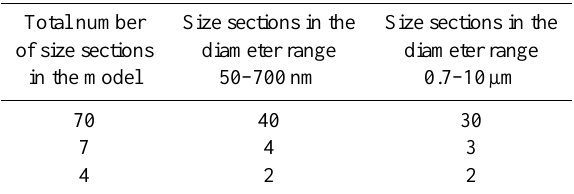
Table 2. Size section configurations of the cloud droplet formation parameterizations used in